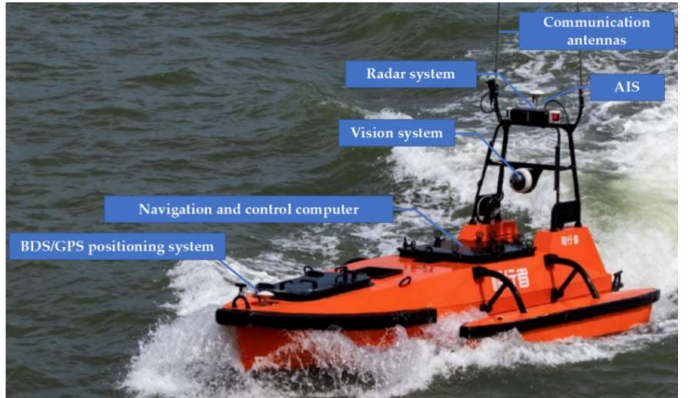
Figure 15. “M80 Polar Walker” USV developed by Yunzhou-Tech Ltd.